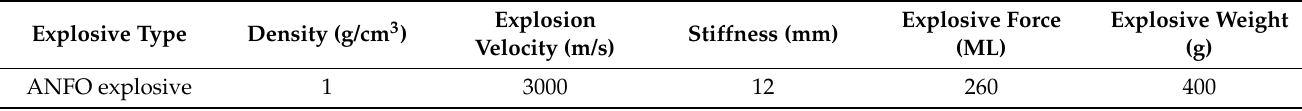
Table 2. Main performance parameters of ANFO explosive.